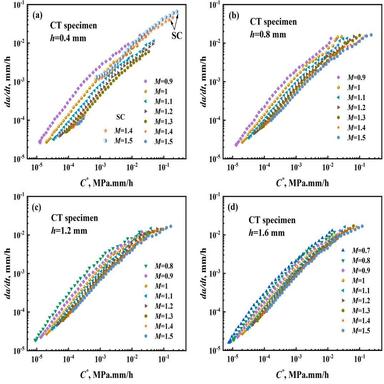
The da/dt-C\ curves for CT specimens at different mismatch factors under weld width of (a) h = 0.4 mm, (b) h = 0.8 mm, (c) h = 1.2 mm and (d) h = 1.6 mm.